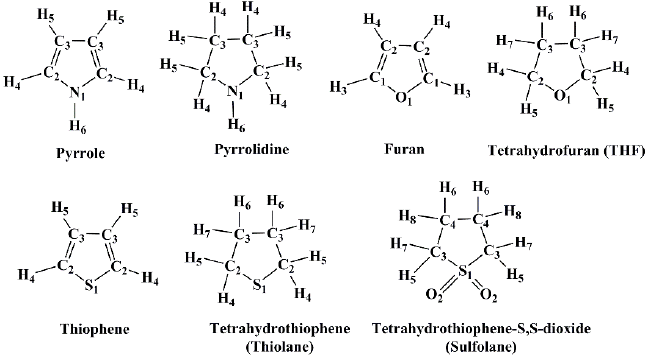
Figure 1. Cyclic molecules studied using the 3D-RISM-KH molecular solvation theory in this work. Equivalent solvent sites are marked with numbers. The highest number refers to the number of solvent sites present in each molecule.